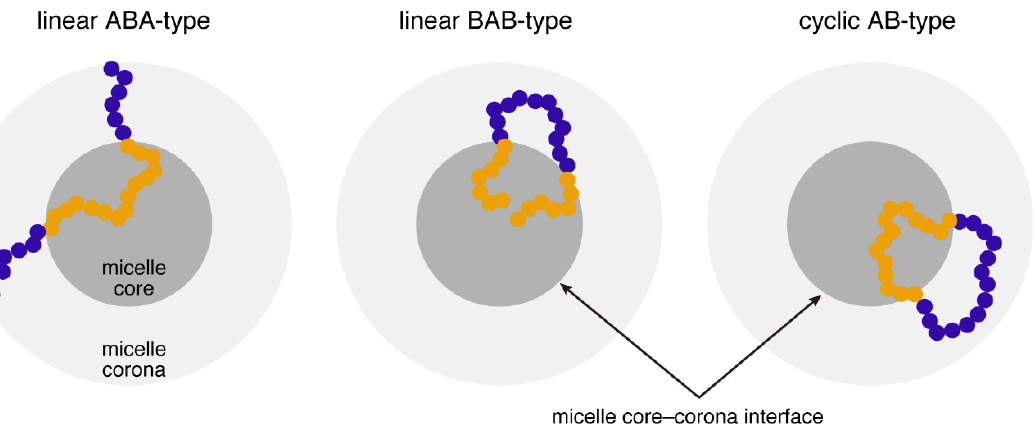
Figure 4. Schematic illustration of the expected conformations of linear ABA-type ( left ), linear BAB-type ( center ), and cyclized ( right ) copolymers in the micellar state. Cyclization results in the fixture of the PEG segment ends at the core – corona interface, and thus, is expected to affect the phase transition phenomena more prominently for the ABA-type copolymer.